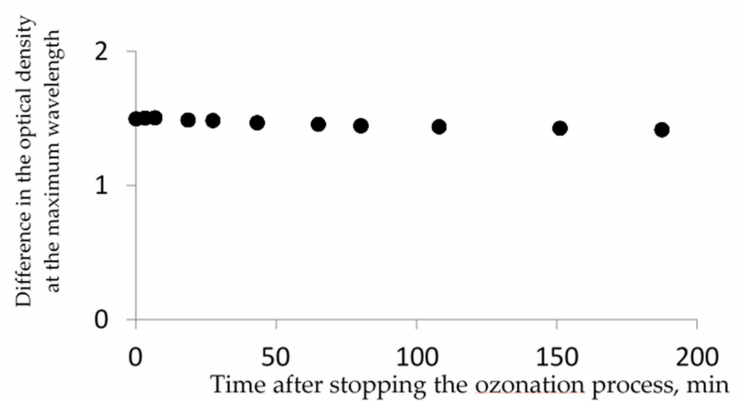
Figure 3. Dependence of the intensity of the absorption band at λ max ~ 288 nm, i.e., the difference in the optical density at the maximum wavelength vs. time after stopping the ozone flow. Ozonation time 19 min. [O 3 ] = 100 mg/L.